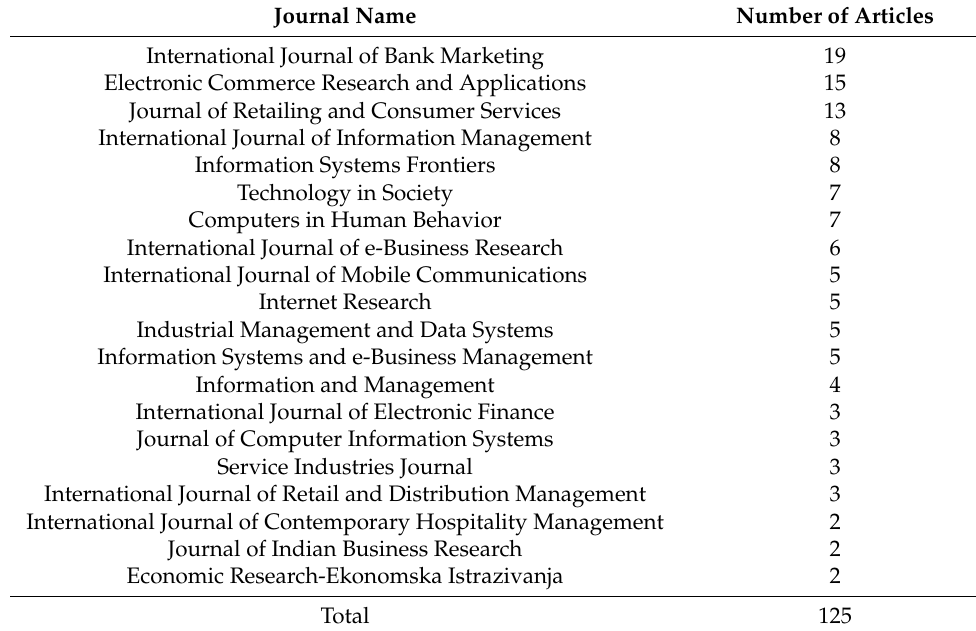
Table A1. The most productive